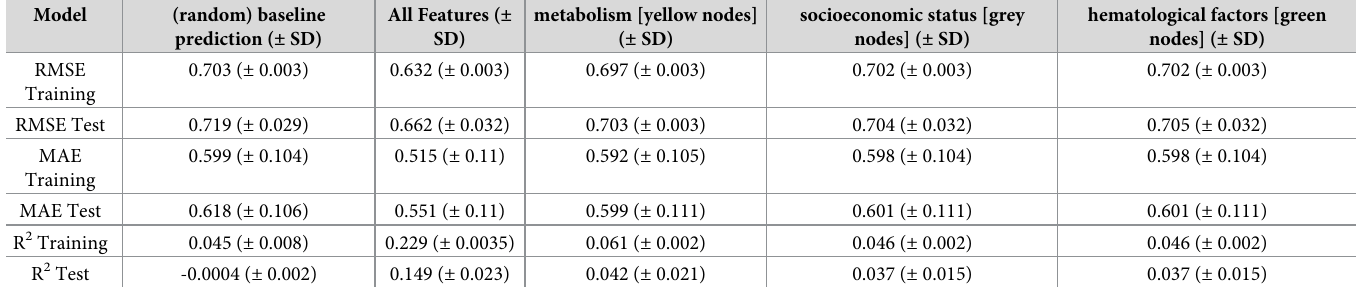
Table 4. RF prediction results for different feature subgroups. Columns refer to models built based on different feature subgroups. The first two rows show the respec- tive RF hyperparameters. The remaining six rows contain the prediction metrics achieved by the models. Average results are stated with standard deviations given in